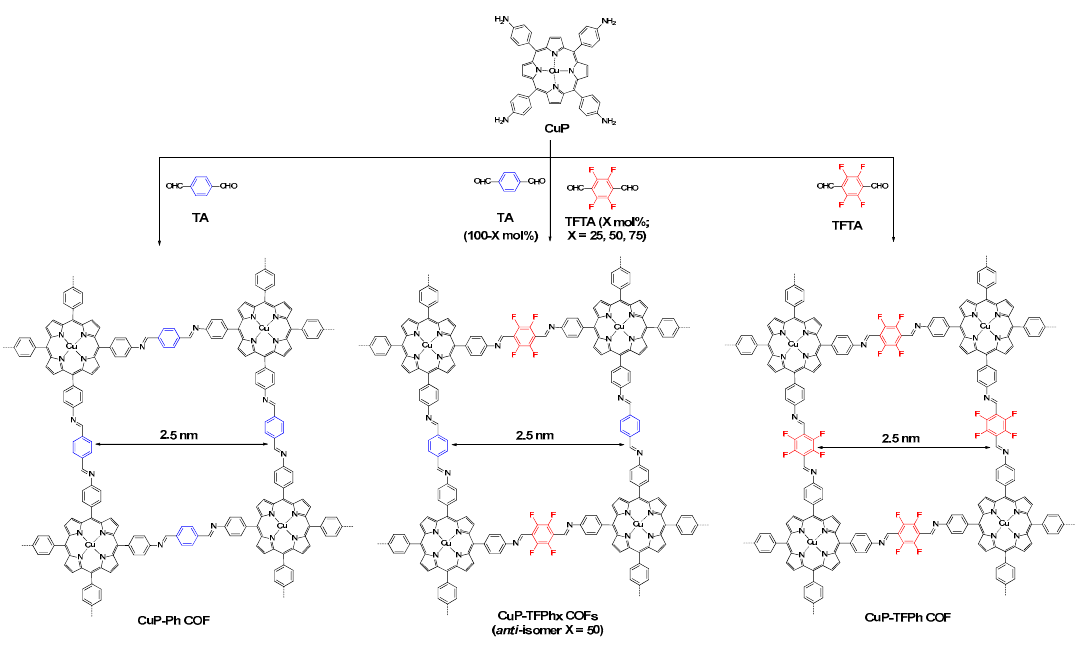
Figure 13. Schematic of the synthesis of 2D COFs integrated with self-complementary π -electronic forces (CuP − TFPh X , X = 25, 50, and 75 mol %) and the CuP − Ph and CuP − TFPh controls. They controlled the crystal structure of CuP-Ph COF by introducing 2,3,5,6-